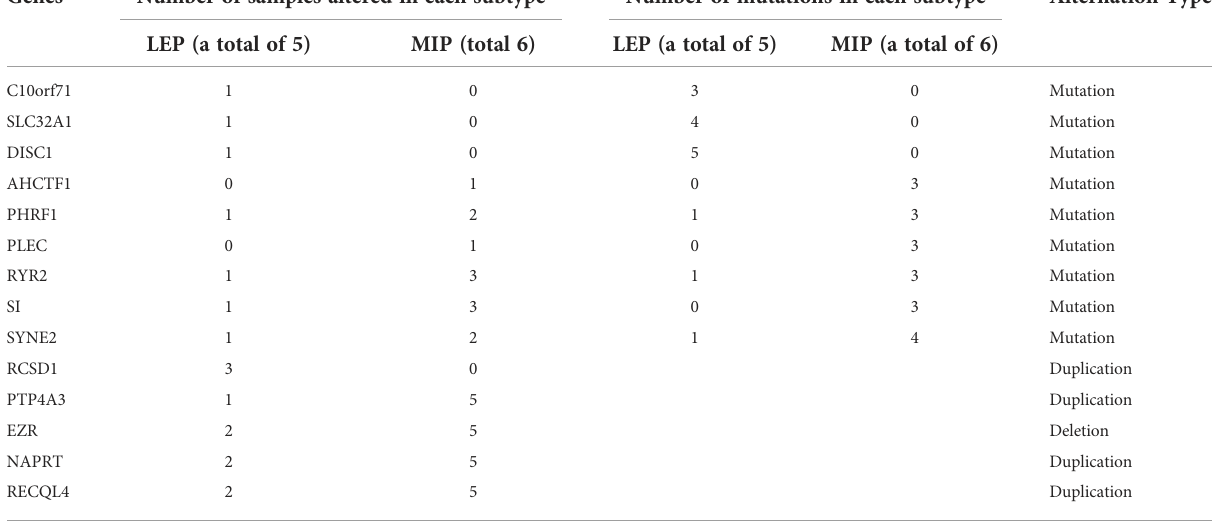
TABLE 1 Genes exhibited subtype-speci fi c alternation frequency among the sequenced samples. Genes